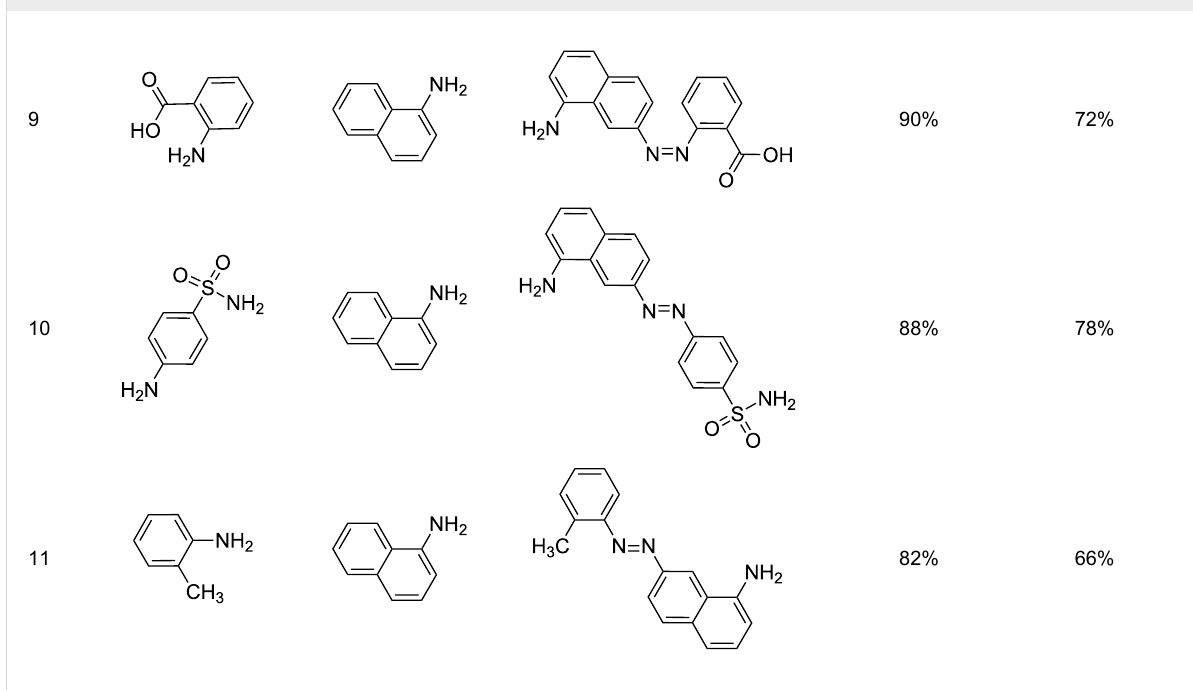
Table 8: Comparison of reaction conversion attained from two continuous flow reactor systems. (continued)